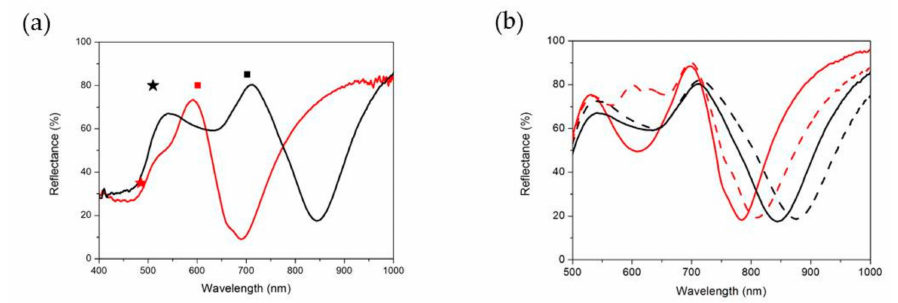
Figure 6. ( a ) Reflectance spectra for two gratings having lattice pitch of 500 nm (black line) and 400 nm (red line). The stars and the squares point out the calculated gold / air and gold / glass polariton wavelength, respectively. ( b ) Solid black and red lines correspond to the reflectance spectra recorded for two gratings having the same lattice pitch (500 nm) but di ff erent hole size. Dashed lines show the spectra acquired for the two samples when water is dispensed on the grating surface. These graphs are obtained from unpublished data from the